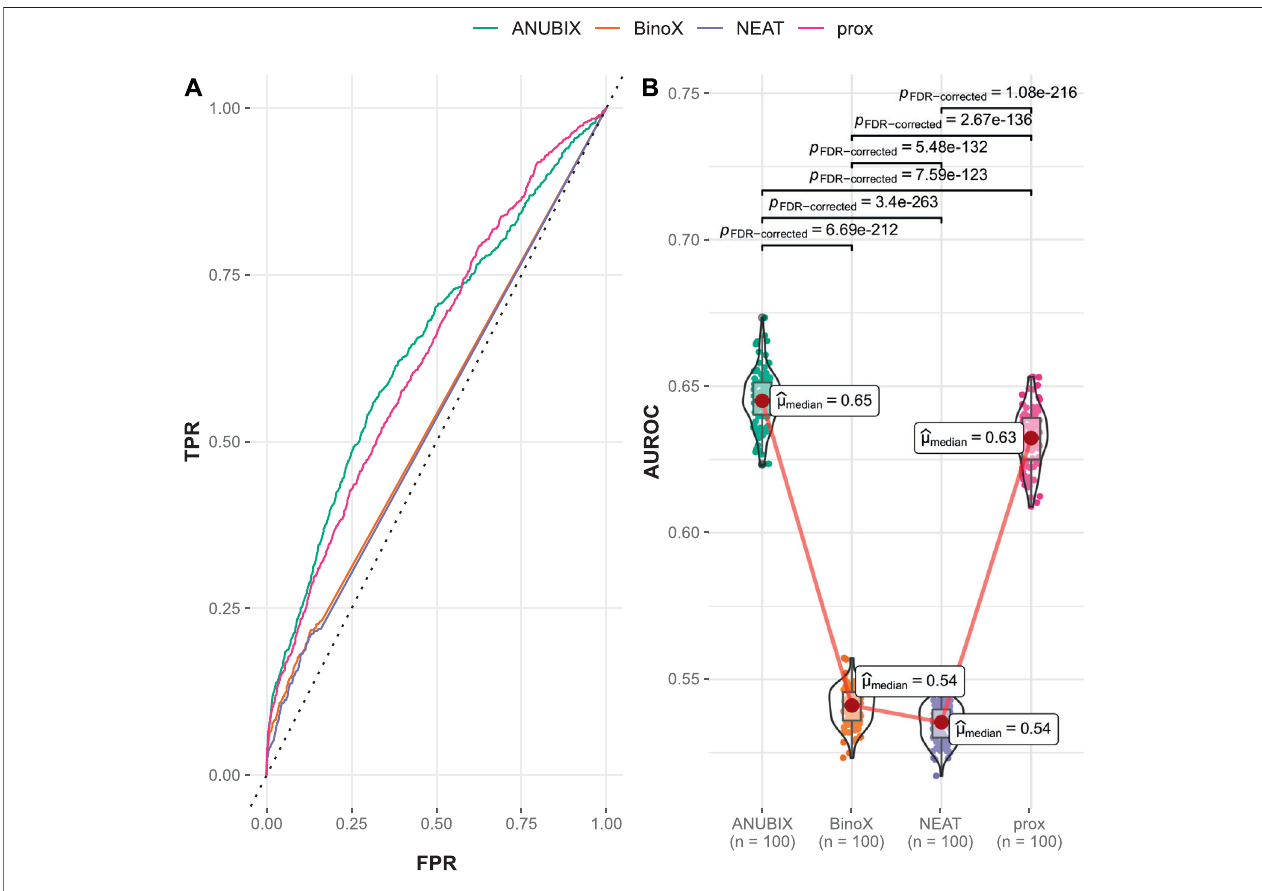
FIGURE4| Drug – diseaseassociation – basedperformanceonthetime-stampedbenchmark.Performanceofthedifferentdrugrepurposingtools:ANUBIX(green), BinoX (orange), NEAT (purple), and proximity (prox, pink) on (A) ROC curves, where the dotted line represents random prediction, and (B) AUROC using sampled sets from the benchmark containing equal numbers of positive and negative drug – disease combinations. The pairwise Wilcoxon rank sum test was used to assess the signi fi cance of difference on AUROC. FDR-corrected p -values were obtained using the Benjamini – Hochberg procedure.